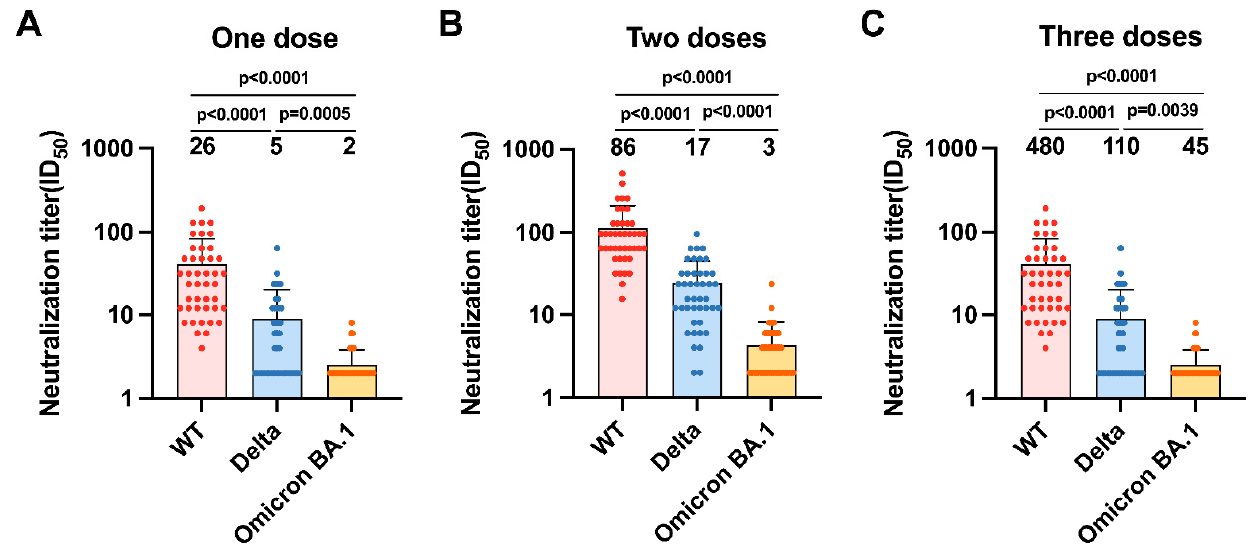
Figure 3. ( A – C ) The results of cross-neutralization of wild-type (WT), Delta, and Omicron BA.1 viruses by sera from each individual vaccinated with one ( A ), two ( B ), and three ( C ) doses of CoronaVac are shown as bar graphs. The numbers on the graph represent the geometric mean titers (GMT).